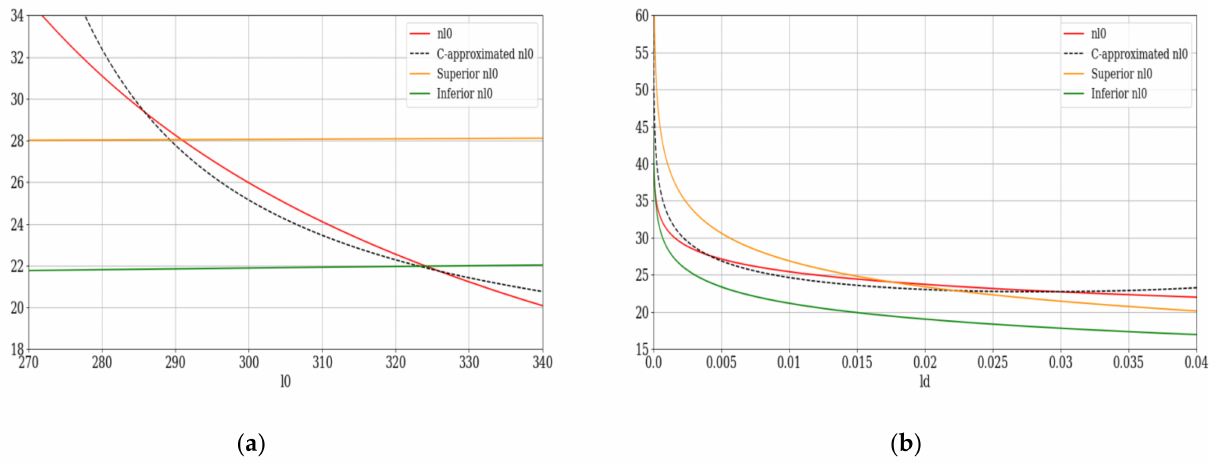
obtained with two initial 0